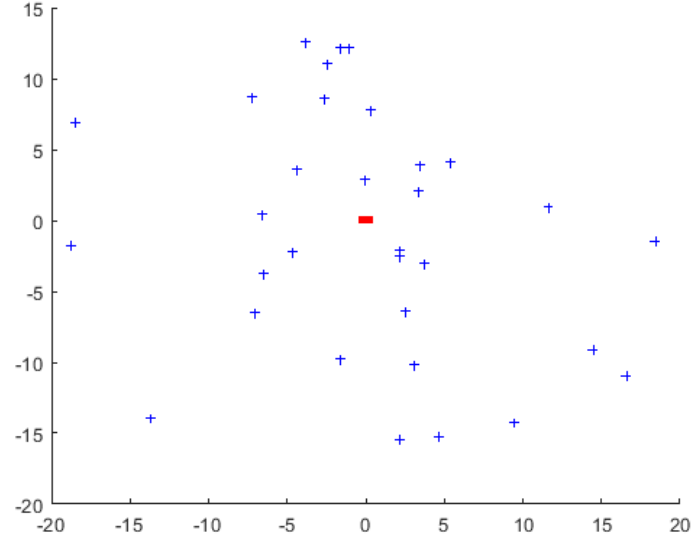
Figure 4. Access point (red) and mobile station (blue) locations for a single